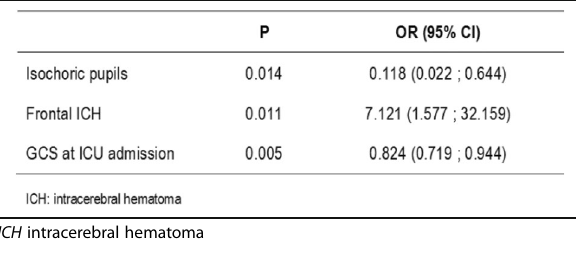
ICH intracerebral